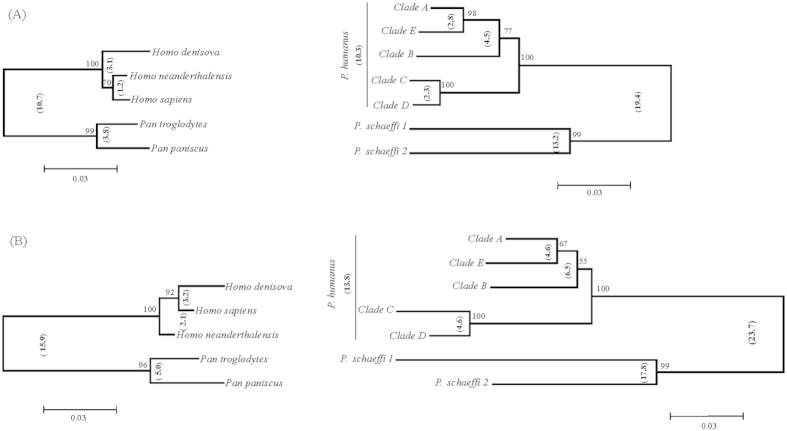
COI (A) and cytb (B) NJ analysis of hominids (left) and their parasitic lice (right).Numbers in brackets between tree branches indicate nearest-neighbor K2P distances.